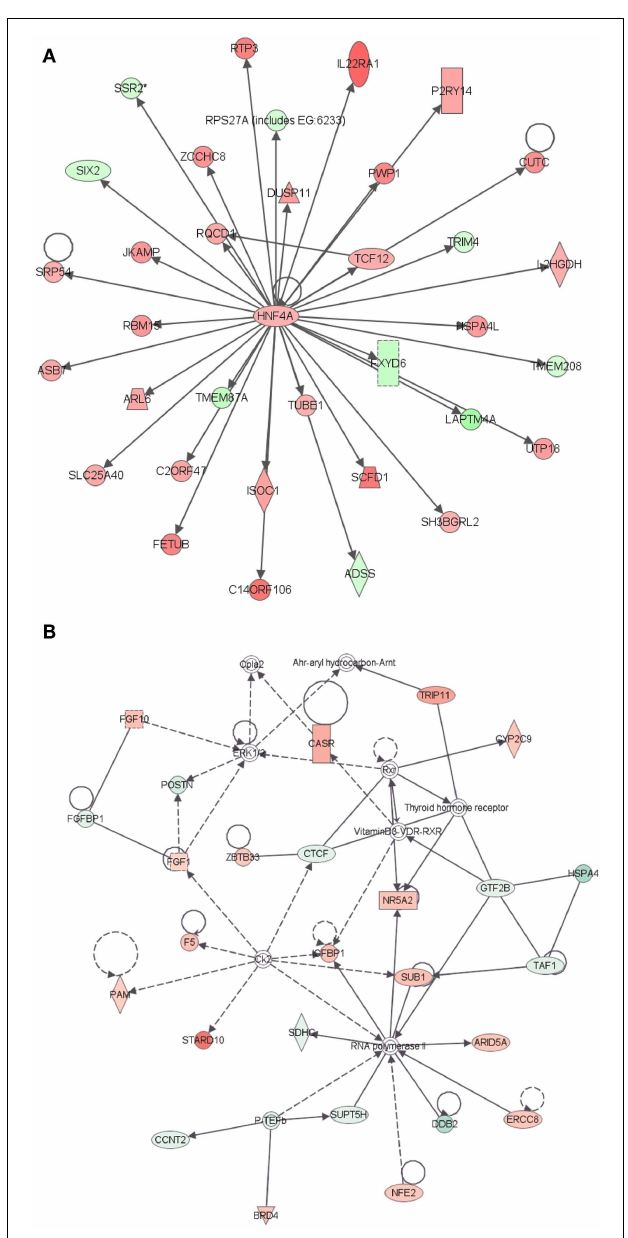
FIGURE 2 | Ingenuity PathwayAnalysis (IPA) of genes differentially expressed in LRECb vs. ECb. Genes that were differentially expressed in LRECb vs. ECb were imported into IPA software, which revealed the involvement of several networks pertinent to LRECb. Network (A) pertains to cellular growth and proliferation and shows a single module with HNF4A at its hub. Network (B) relates to cell cycle and post translational modification. Red color denotes up-regulation in LRECb and green color denotes down-regulation in LRECb relative to control cells.The IPA legend is shown in FigureA1 in Appendix.